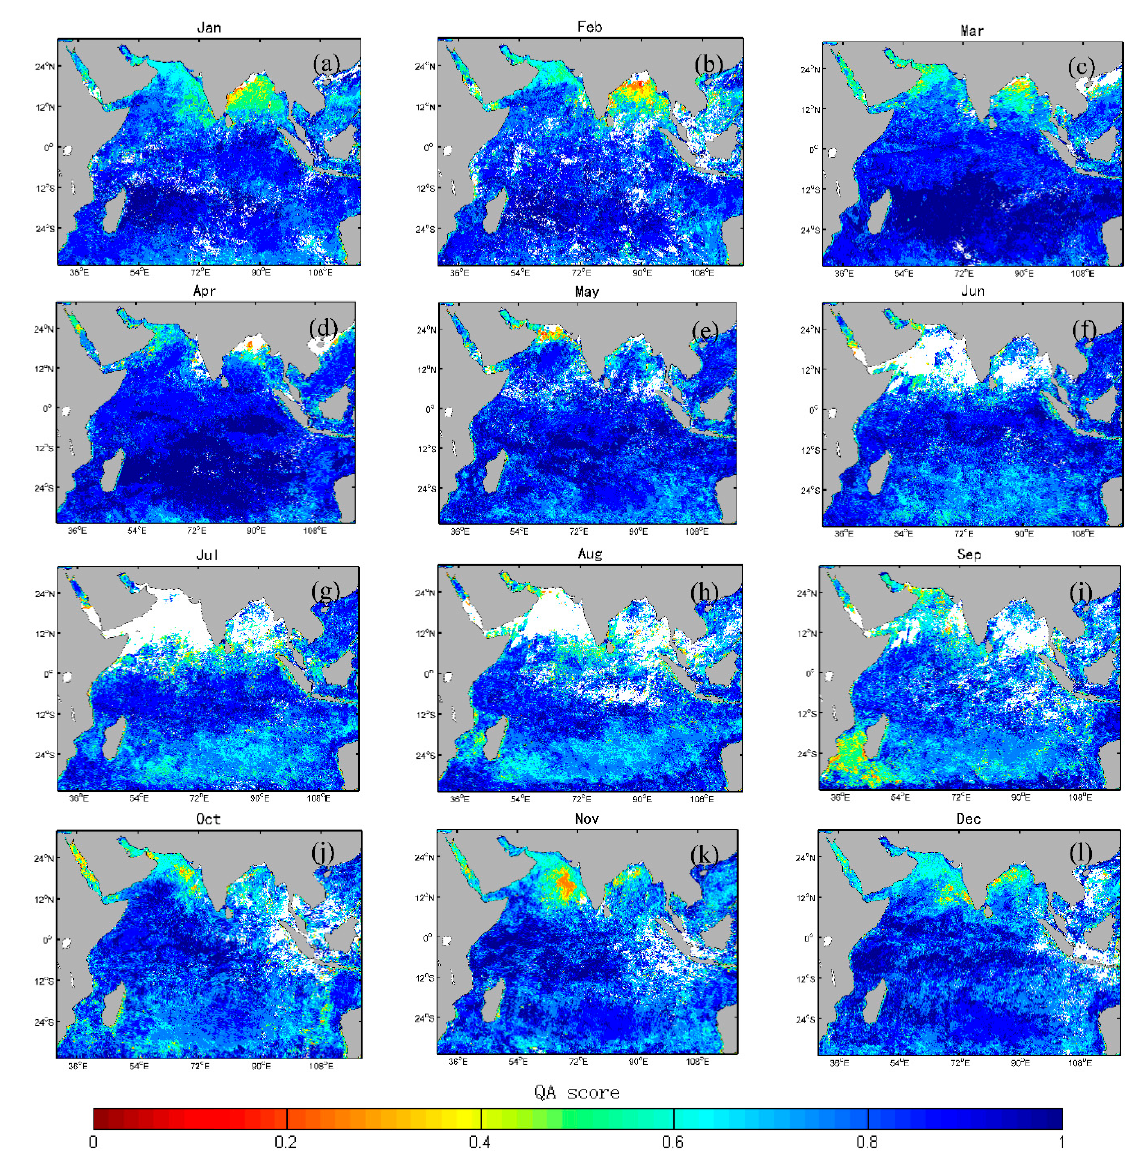
Figure 8. Monthly QA scores of MODIS–Terra level 3 R rs ( λ ) products (R2014) from January ( a ) to December ( l ) in 2016 in the IO. The white color represents invalid pixels.